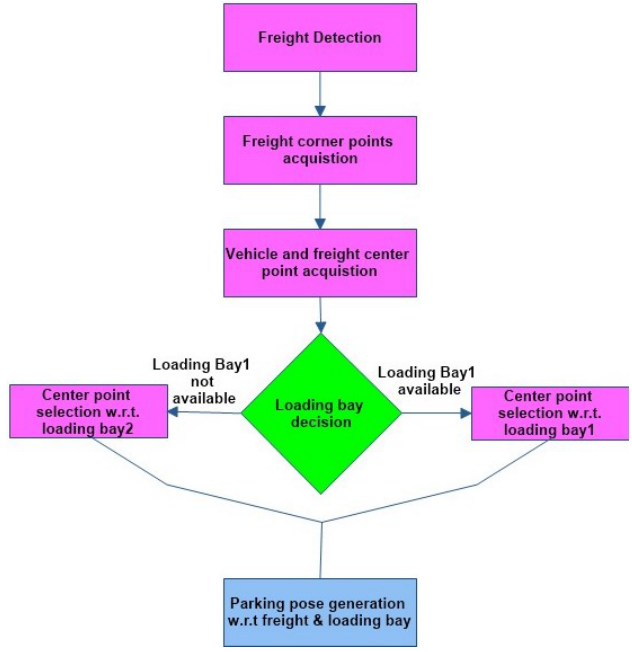
Figure 9. Flowchart for parking pose